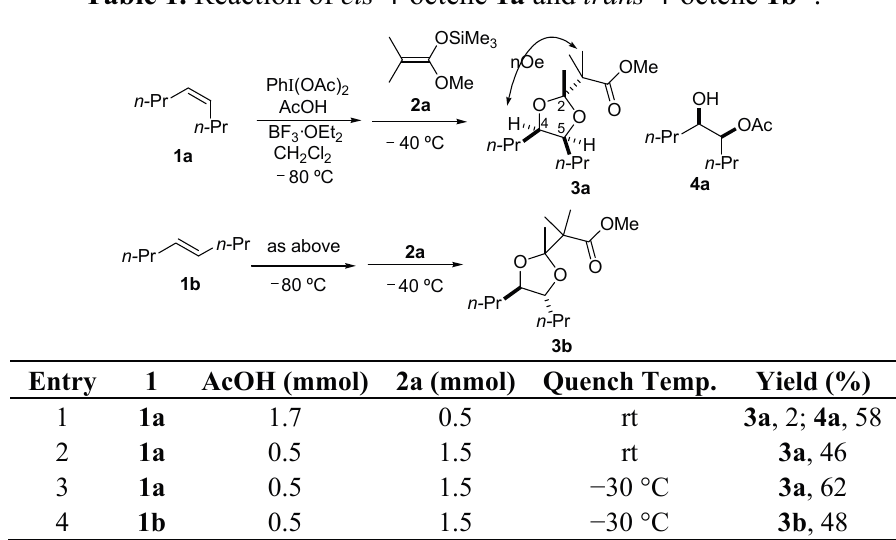
Table 1. Reaction of cis -4-octene 1a and trans -4-octene 1b a